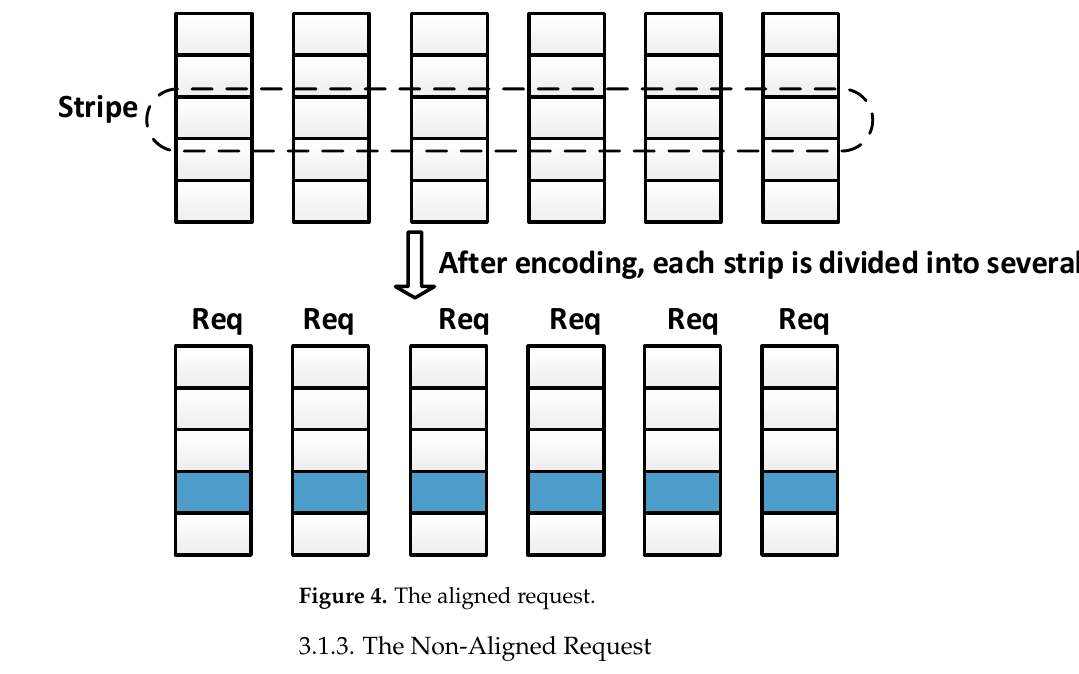
Figure 4. The aligned request.